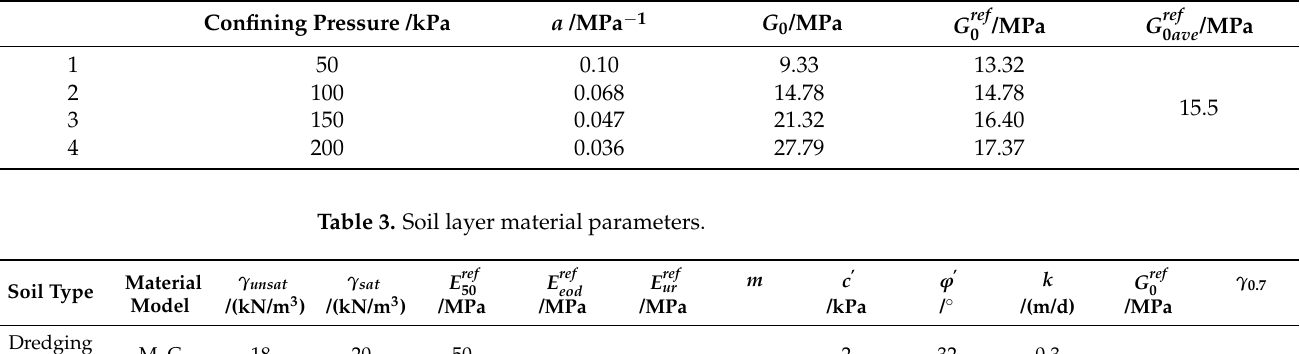
Table 2. Reference dynamic shear modulus of each sludge sample under different confining pressures.